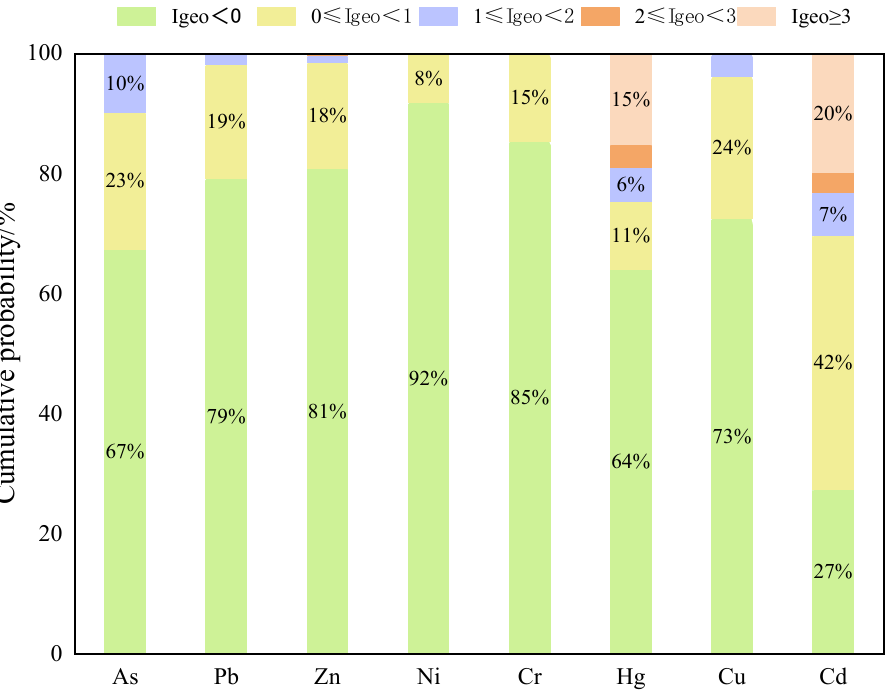
Table 5. Potential ecological risk assessment results of sediments in Weihe River Basin.